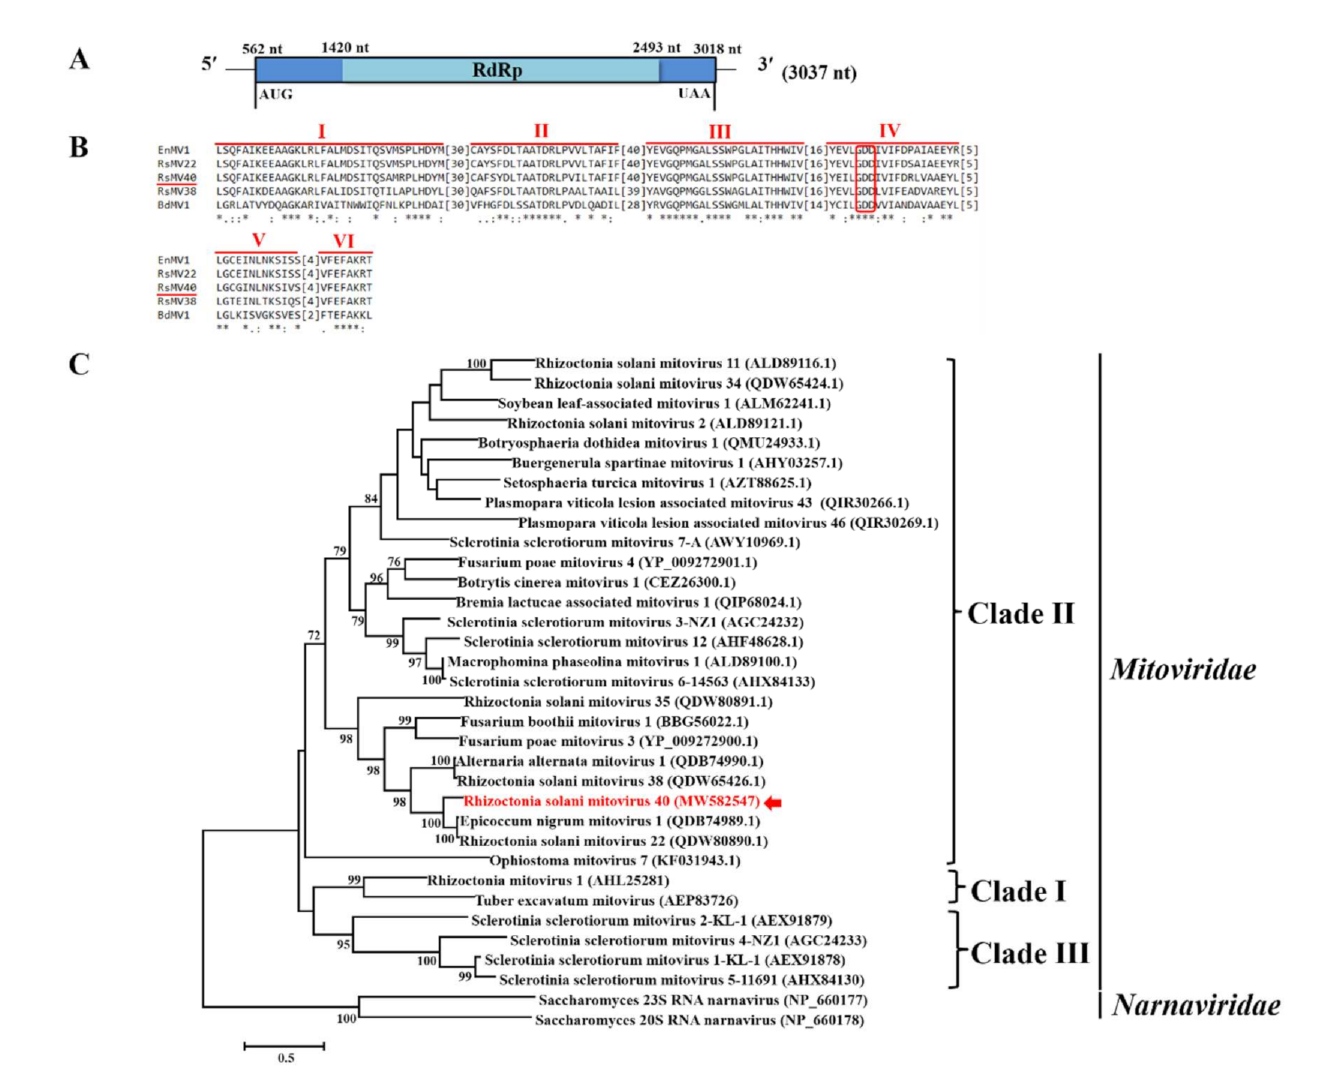
Figure 3. Genome organization, multiple alignments of amino acid sequences of RNA-dependent RNA polymerase (RdRp), and phylogenetic analysis of amino acid sequences of RdRp of Rhizoctonia solani mitovirus 40 (RsMV40). ( A ) Schematic diagram illustrating the genome organization of RsMV40. RsMV40 contains a single open reading frame (ORF) encoding RdRp, which is initiated by an AUG codon and is terminated by a UAA codon. ( B ) Multiple alignment of aa sequences of RdRp of RsMV40 and four representative mitoviruses. The presence of six conserved motifs (I to VI) is shown. The highly conserved GDD tripeptide present in the five mycoviruses are indicated by red boxes. “*” indicates identical amino acids, “:” indicates high chemically similar amino acids, and “.” indicates low chemically similar amino acids. ( C ) Phylogenetic analysis of aa sequences of RdRp of RsMV40 and 31 other representative members of the family Mitoviridae and two narnaviruses. Viruses in the family Mitoviridae were clustered in three clades (Clade I, Clade II, and Clade III), and RsMV40 (red arrow) clustered in Clade II. The names and GenBank accession numbers of the reference mycoviruses are listed in Table